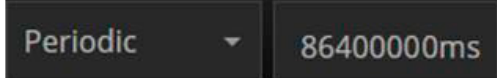
Figure 12. Set Dynamo periodic run interval.